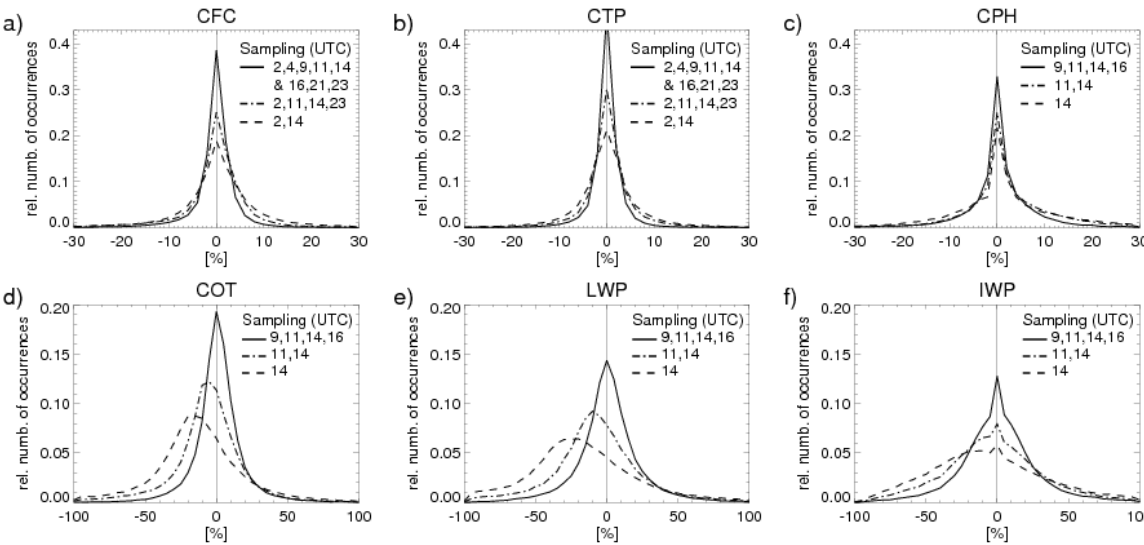
Fig. 8. Relative deviations of monthly means inferred from reduced temporal sampling with respect to the all-day average, for which all available time slots were used. (a) through (f) : cloud fraction (CFC), cloud top pressure (CTP), liquid cloud fraction (CPH), cloud optical thickness (COT), liquid and ice water path (LWP and IWP). For CFC and CTP the monthly means were created from two (02:00, 14:00UTC), four (02:00, 11:00, 14:00, 23:00UTC) and eight (02:00, 04:00, 09:00, 11:00, 14:00, 16:00, 21:00, 23:00UTC) samples a day, while for CPH, COT, LWP and IWP the monthly means were created from one (14:00UTC), two (11:00, 14:00UTC) and four (09:00, 11:00, 14:00, 16:00UTC) samples a day. The data shown are for July 2011 and regions between − 20 ◦ and 20 ◦ longitude and with satellite zenith angles lower than 72 ◦ . Note the different scaling of the axes for CFC, CTP and CPH compared to COT, LWP and